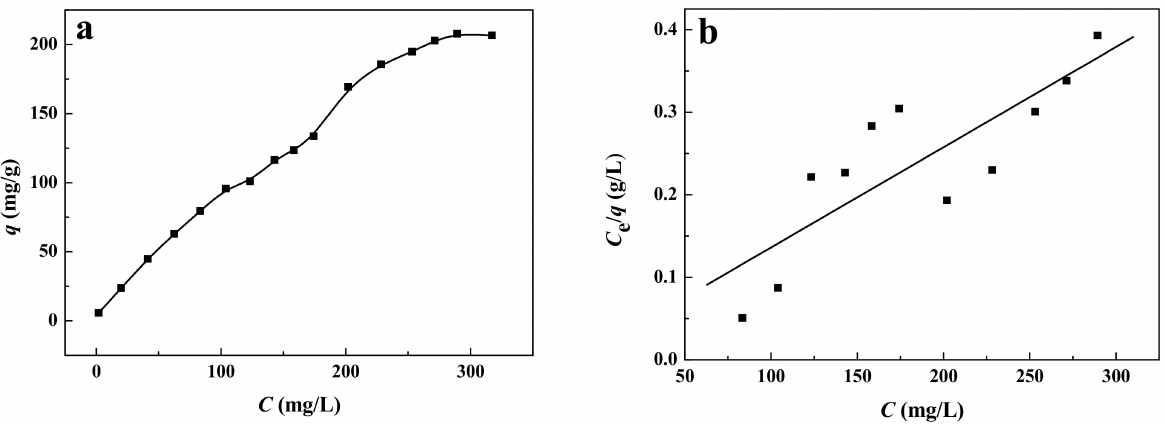
Figure 8. ( a ) Effect of the initial dye concentration on adsorption performance and ( b ) C e / q - C